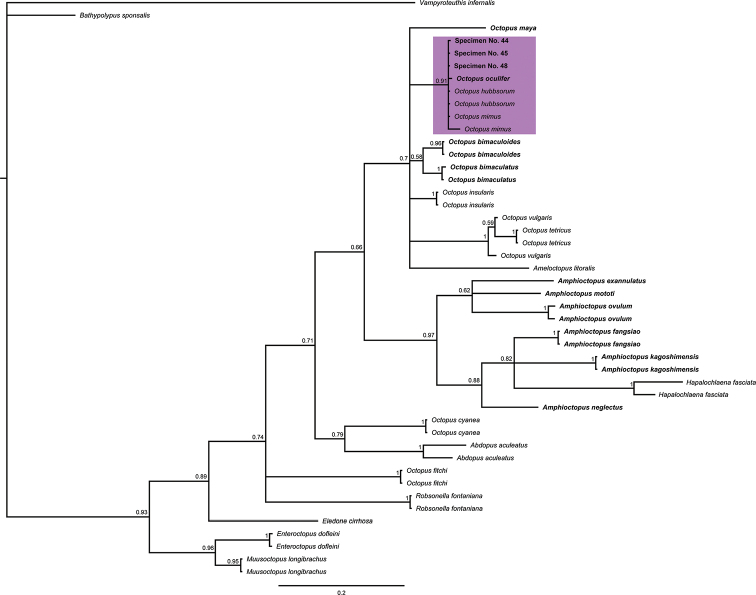
COIII Molecular phylogeny. Molecular phylogeny of COIII-gene sequences (273 bp: 136 variable and 137 conserved) of ocellate and non- ocellate octopus species. Ocellated octopuses are bold-faced. Purple rectangle indicates the clade containing the specimens evaluated in this study.